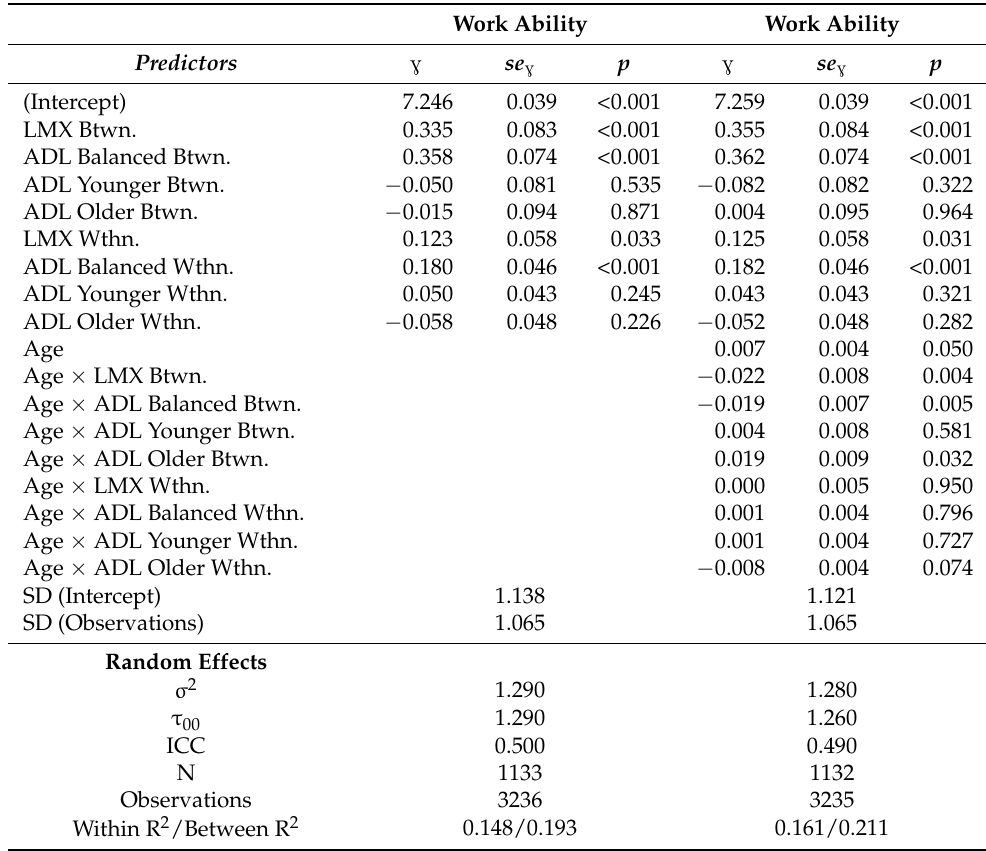
Table 3. Summary of Mixed Effects